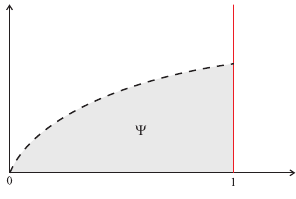
Figure 3. Subregion in the phase plane where it is possible to apply the Poincar´e-Bendixson theorem. with θ = ( A, B, H, S ). The Jacobian matrix is